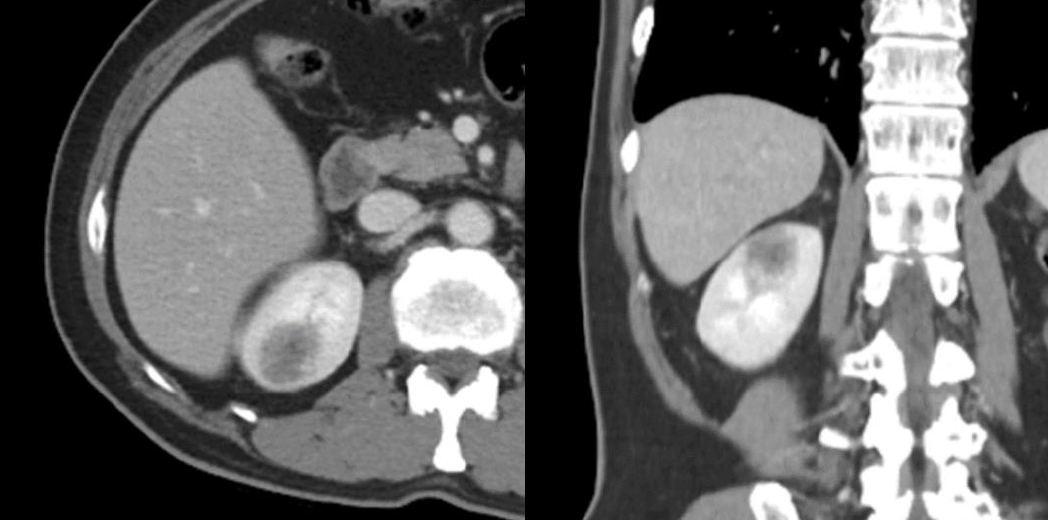
Figure 5. A hypodense lesion of 2.0 cm was observed in the upper pole of the right kidney.